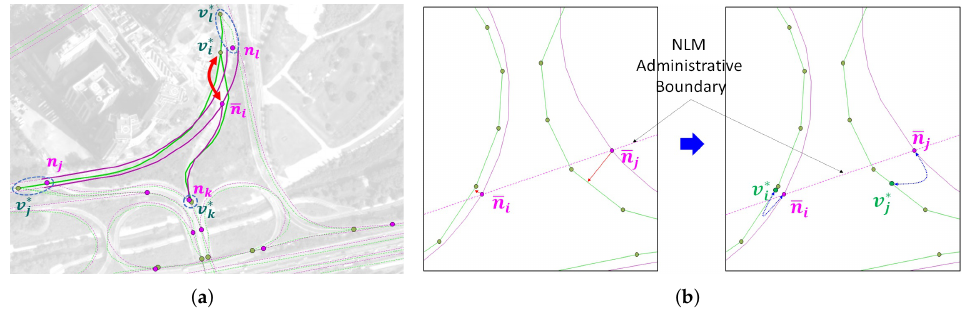
Figure 9. Examples of unmatched single NLM node n i in ( a ) merging lane and ( b ) administrative